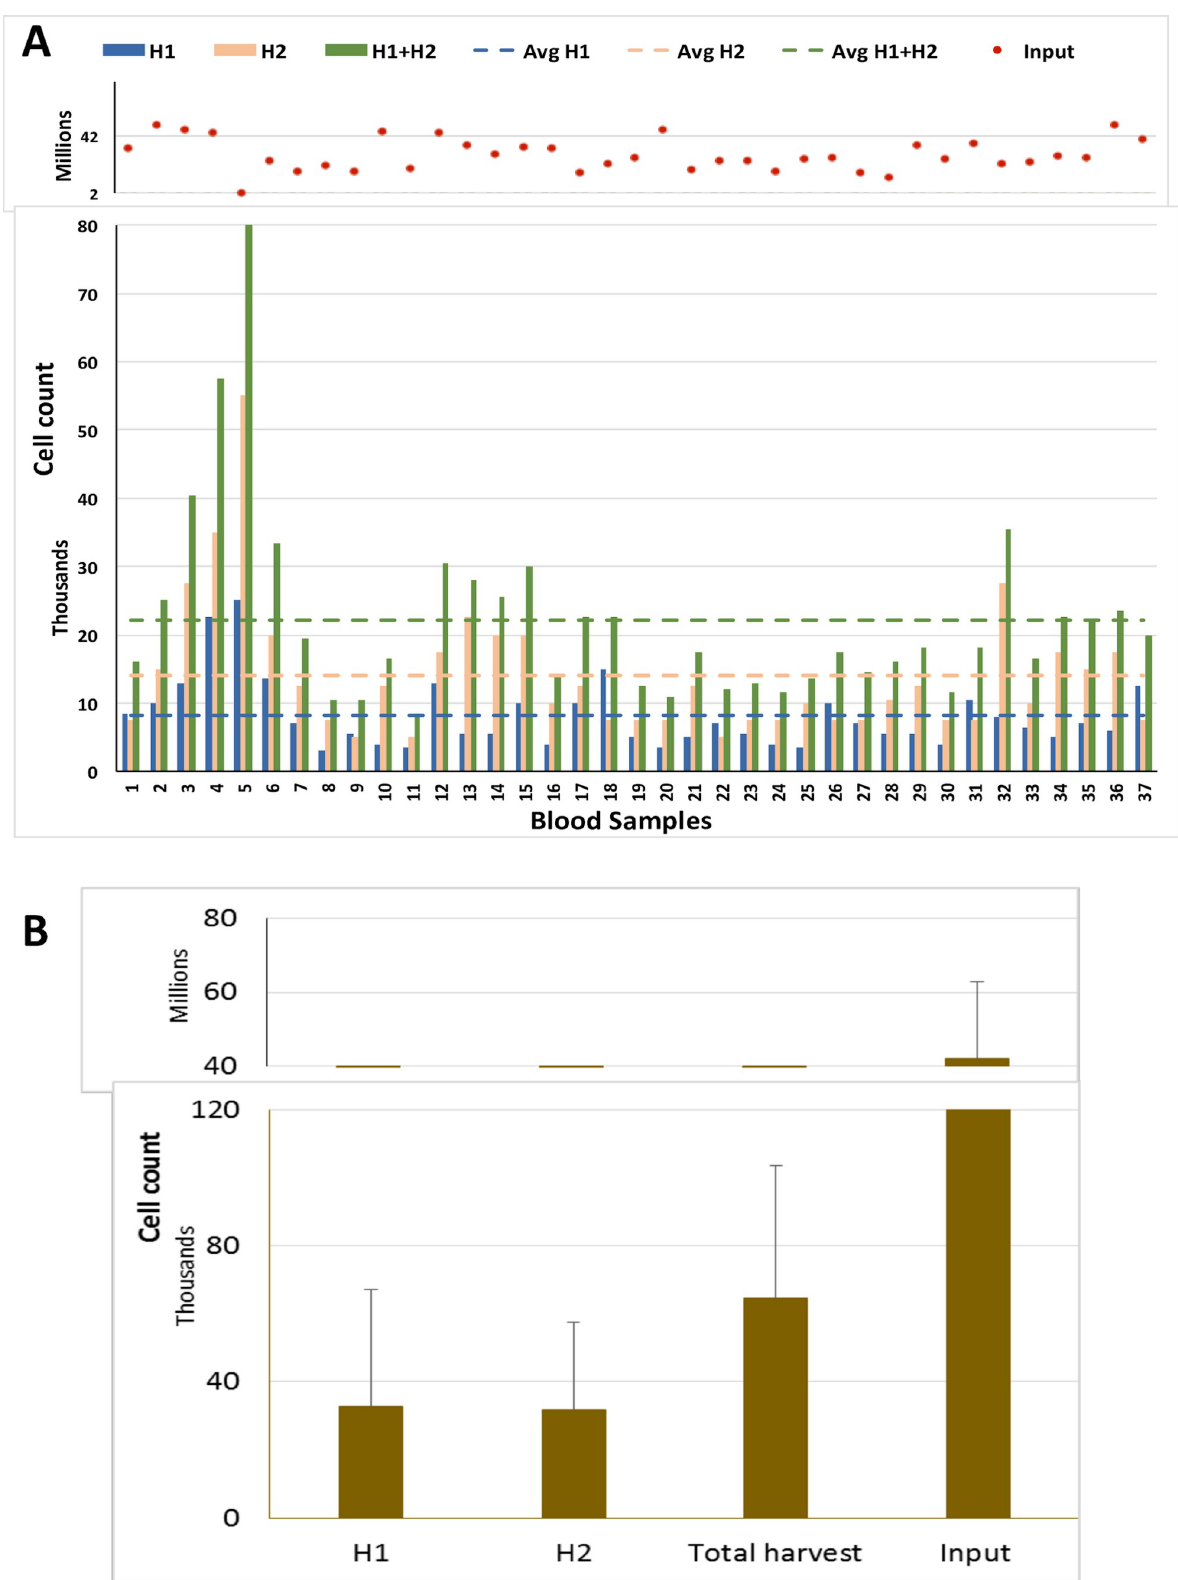
Fig 4. Yield of nucleated cells in Blood samples from metastatic patients using Parsortix system.